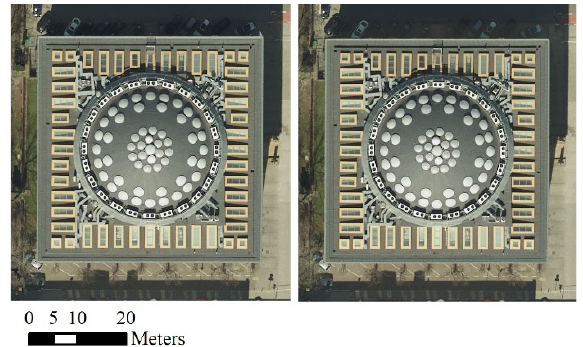
Figure 2. The example of the building located in the area